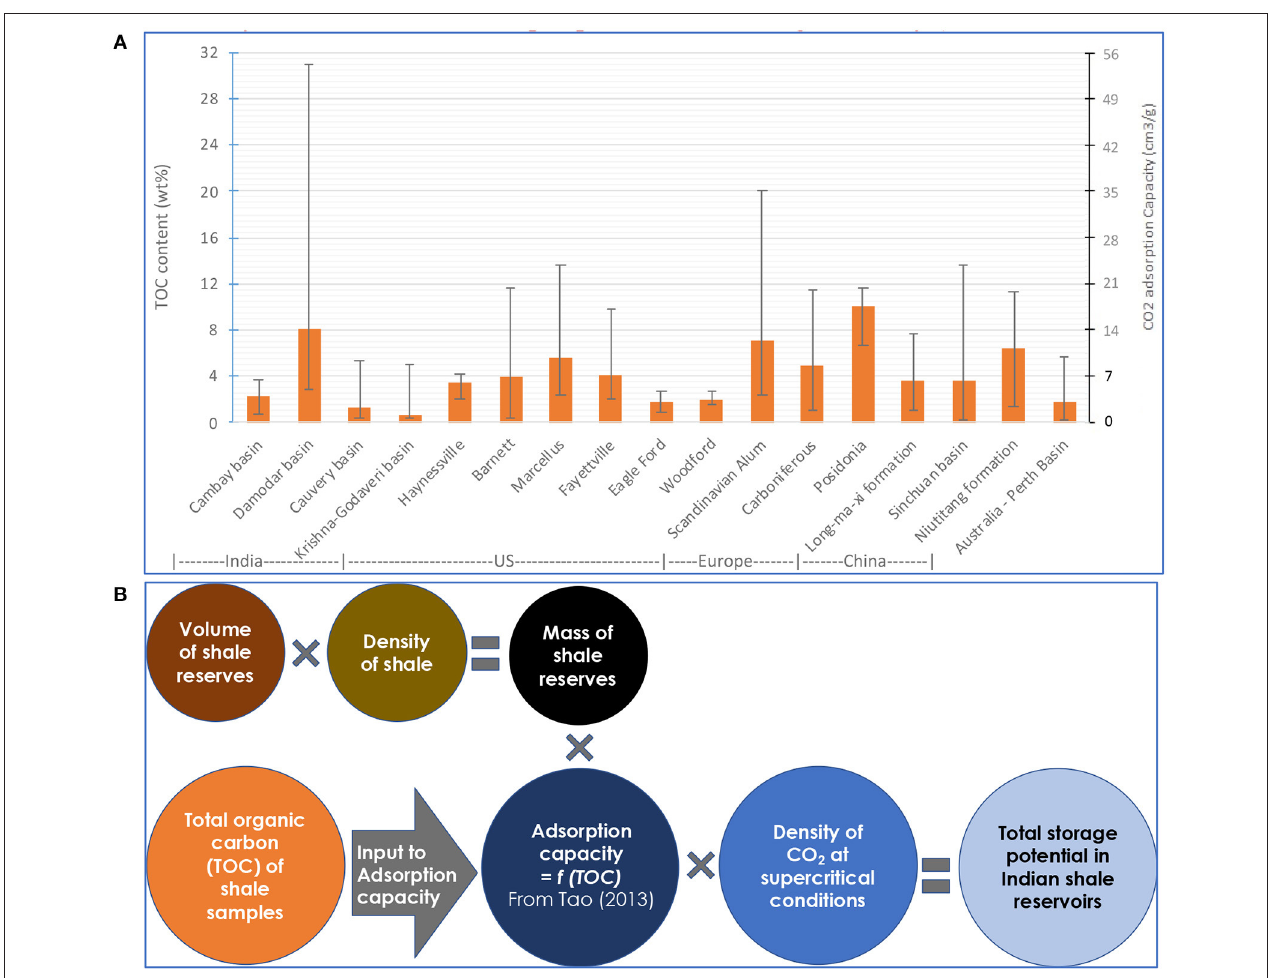
FIGURE 1 | (A) Total Organic Carbon (TOC) comparison of different shales explored worldwide. Data sources can be found in Supplementary Table 2 of the SI. Samples were collected at different depths for each of the basins and the TOC correspond to individual depths. The heights of the orange bars represent the medians of the values from the literature ( Supplementary Table 2 ) and the ranges illustrate the variability of the TOC. (B) Suggested methodology to utilize TOC and existing volumetric data to estimate storage